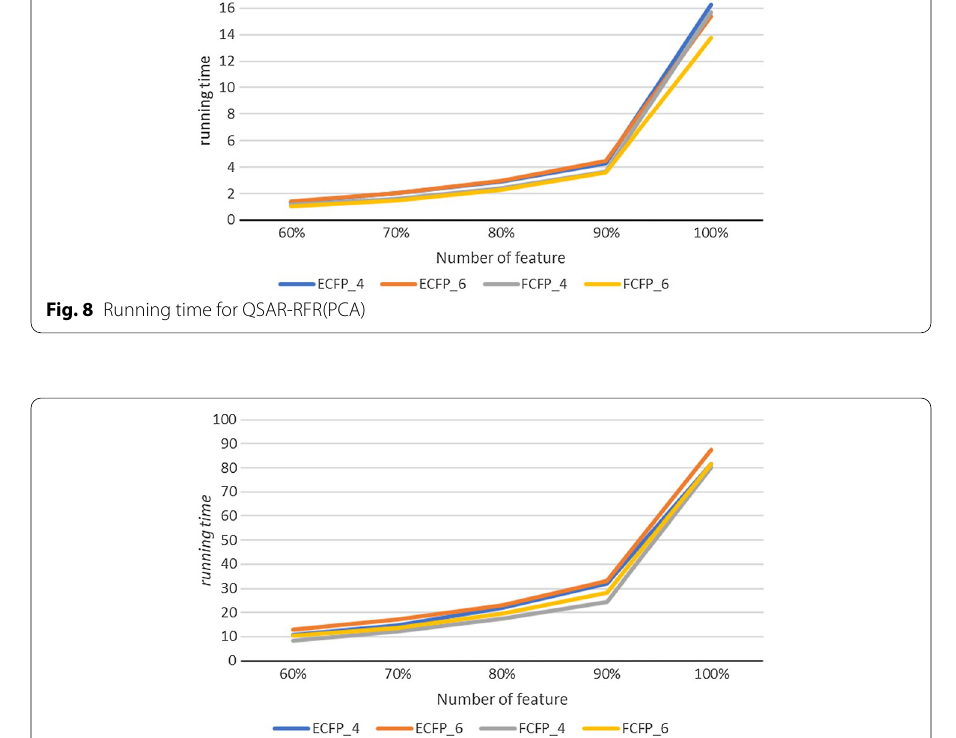
Fig. 9 Running time for